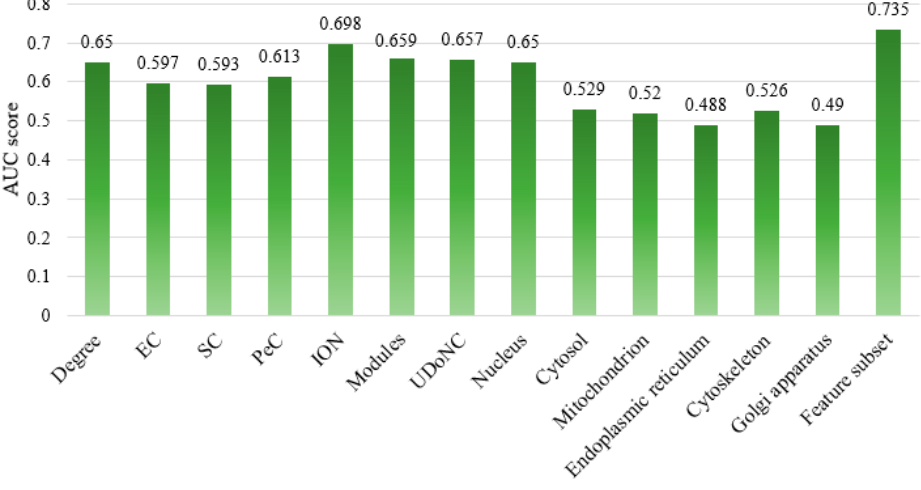
Figure 5. AUC scores of our selected features and those using individual features. Table 3. Comparing the performance evaluations of different feature subsets.